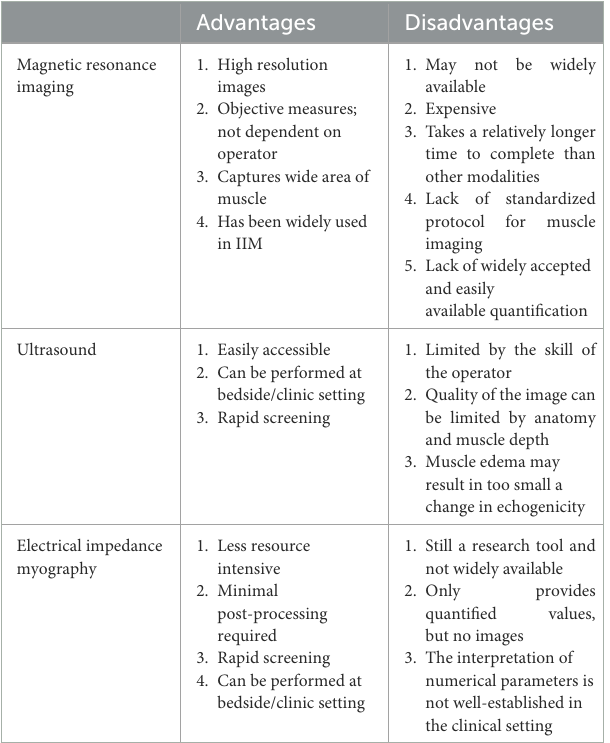
TABLE 1 Advantages and disadvantages of different imaging